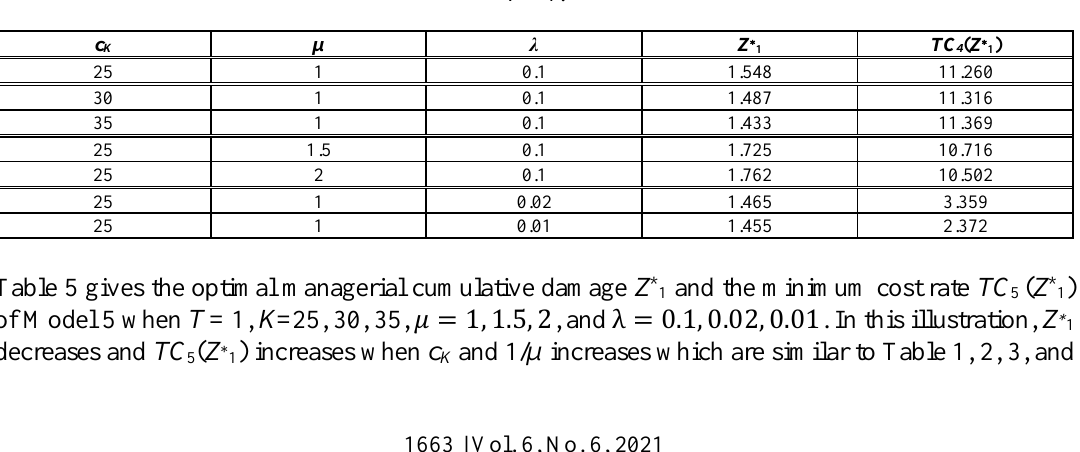
Table 4. Optimal Z ∗ 1 and TC 4 ( Z ∗ 1 ) of Model 4 for K =25, 30, 35, 𝜇 = 1, 1.5, 2 , and λ = 0.1, 0.02, 0.01 when T =